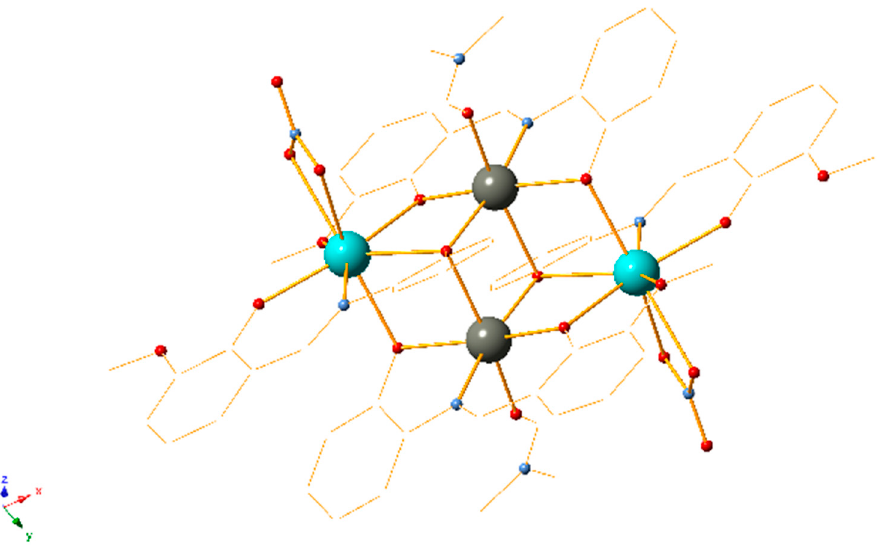
Figure 1. Molecular structure of 1Ln . Colour code: Zn II : grey; Ln III : light blue; O: red; N: blue. C and H atoms are omitted for clarity.